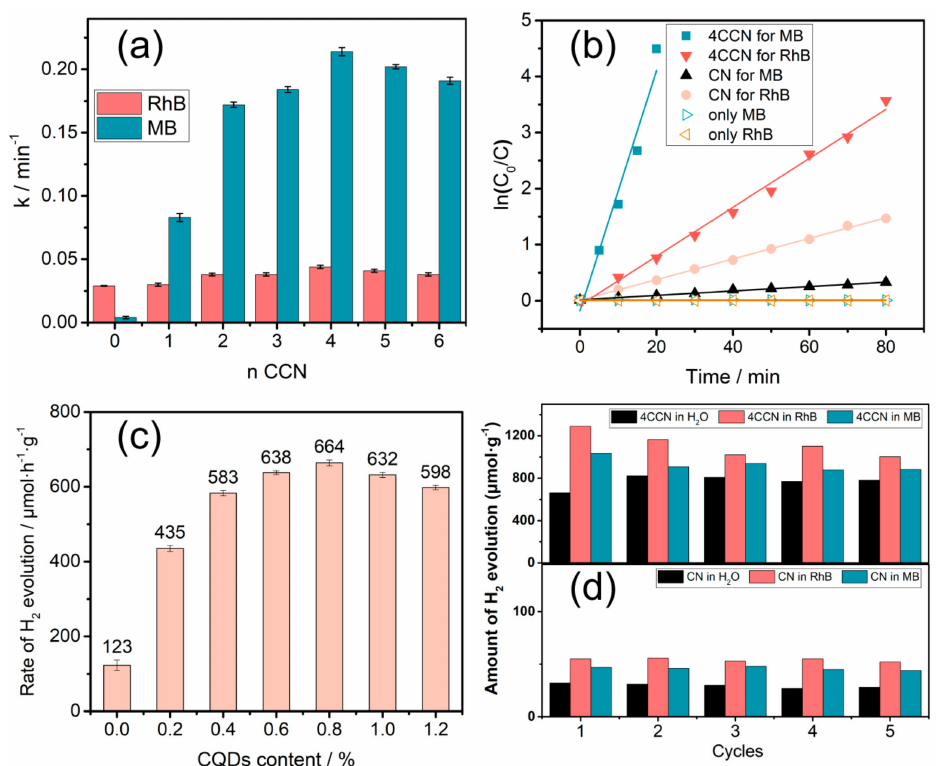
Figure 4. The degradation rate constant of dyes over the g-C 3 N 4 -based samples modified by di ff erent concentrations of CQDs ( a ); photocatalytic degradation profiles of RhB and MB over CN and 4CCN (0.98 wt% CQDs) ( b ); hydrogen evolution rate of the g-C 3 N 4 -based samples modified by di ff erent concentrations of CQDs ( c ); and photocatalytic hydrogen evolution per hour in di ff erent cycles over CN and 4CCN samples ( d ). Error bars represent mean ± s.d. of at least three independent